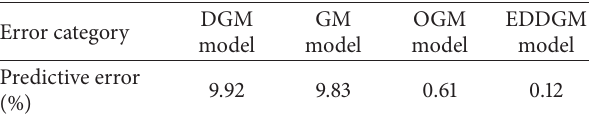
Figure 3: The original data of conflict events in 2008–2014 in China.